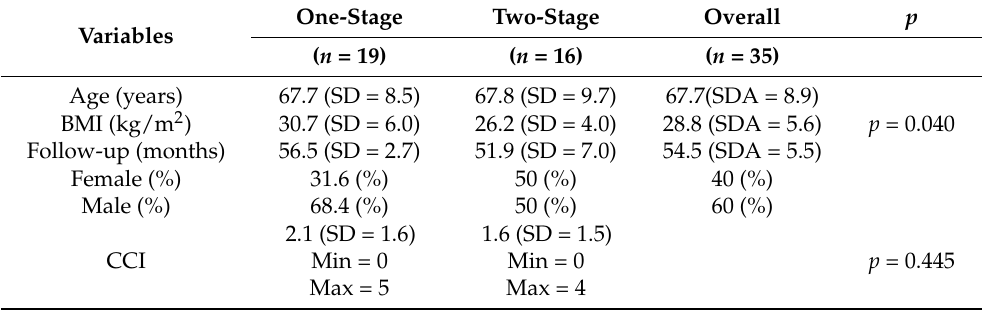
Table 1. Patient characteristics.